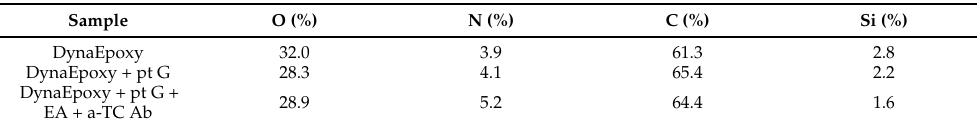
Table 5. Elemental composition (%) determined by XPS analysis. The error does not exceed the 1–2% of the reported value.